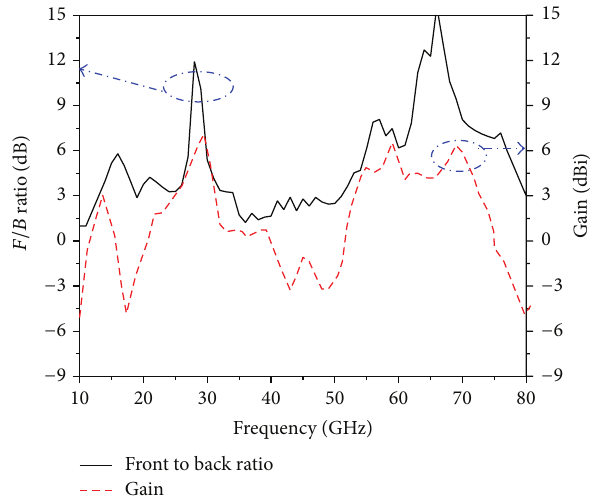
Figure 6: Simulated front to back ratio and gain of the proposed antenna.